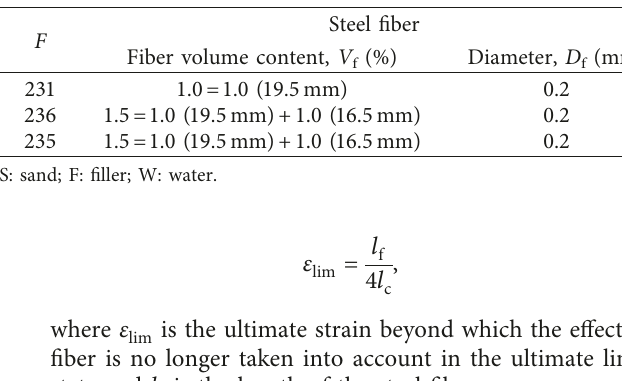
Table 1: Mixing proportions of the UHPFRC.